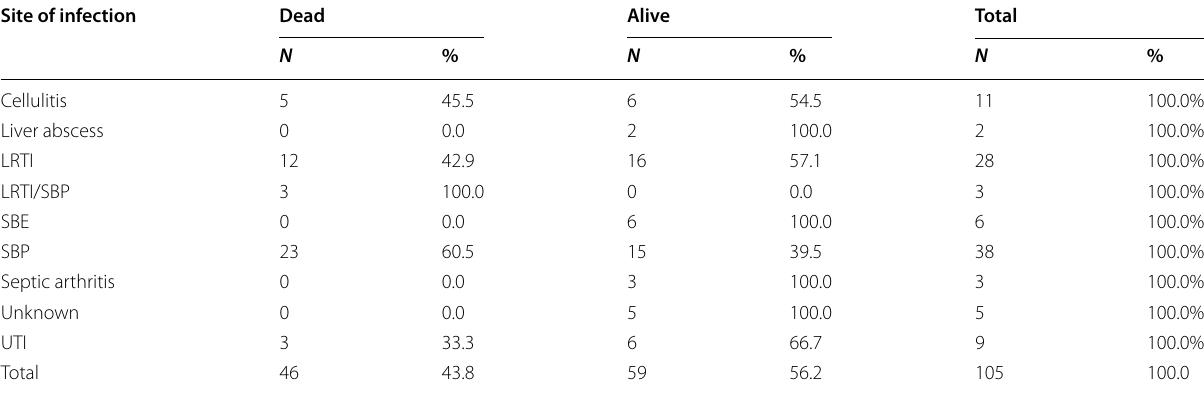
Table 2 Sources of sepsis among the study population Site of infection